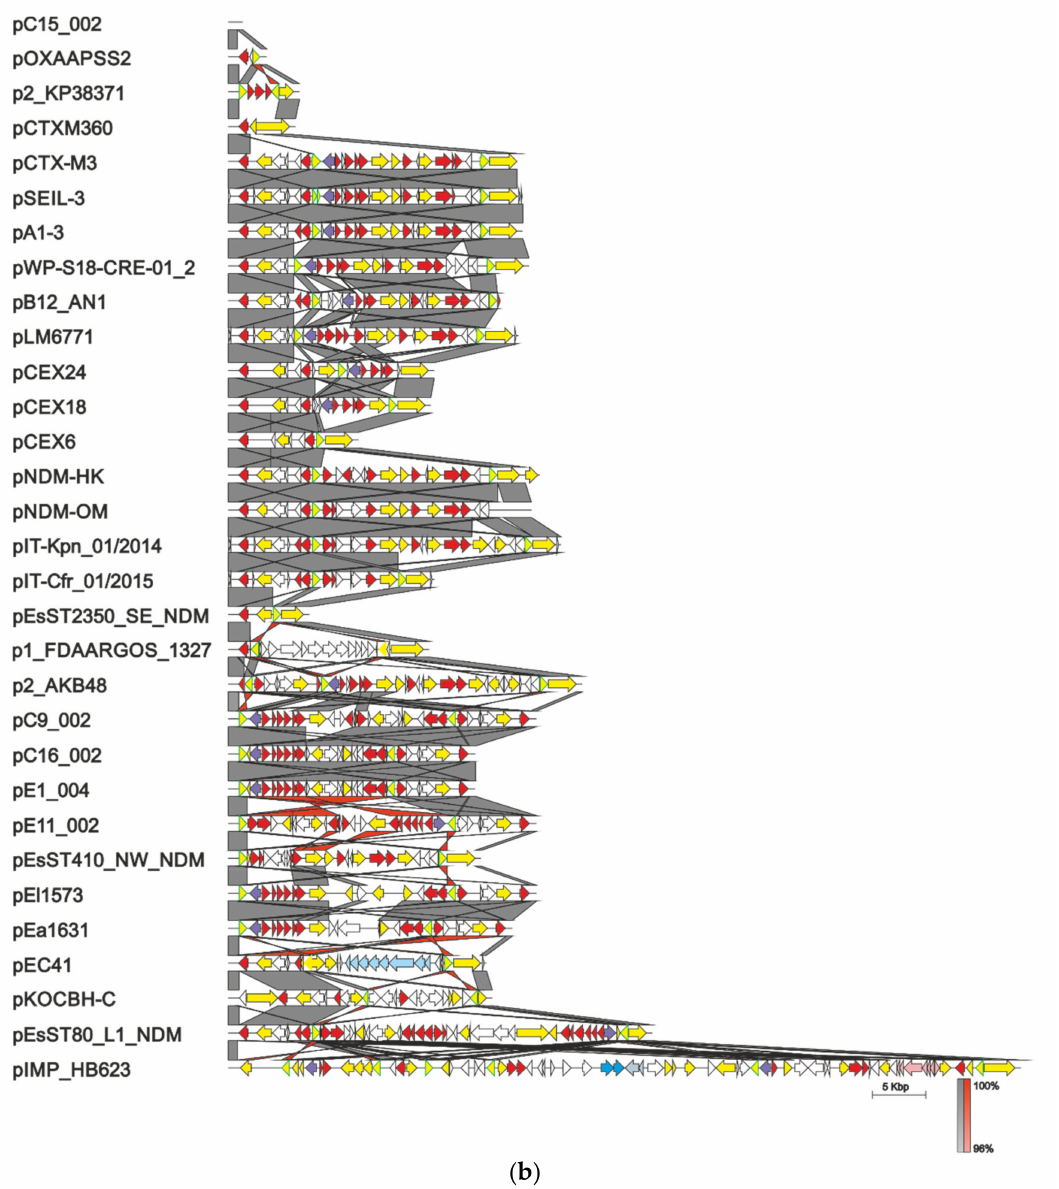
Figure 3. pCTX-M3 family plasmids. ( a ) Alignment of pCTX-M3 and related plasmids; ( b ) Alignment of diverse multiple resistance regions. The ORFs are represented as arrows, rep genes are in black, drug resistance genes in red, mercury- resistance operon in pink, ferric citrate transport genes in pale blue, conjugative transfer genes in green, transposase genes in yellow (IS 26 transposase genes are outlined in green in panel b), integron integrase-encoding genes in violet, parAB and pemIK in blue, mucA and mucB in grey, and others in white. Plasmid nucleotide sequences were taken from